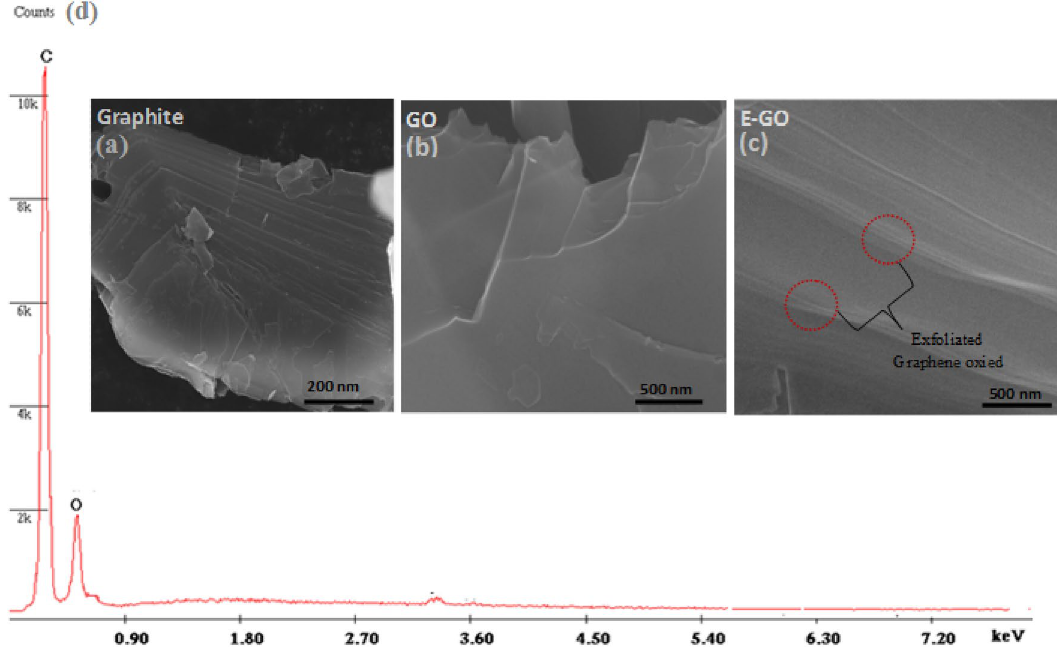
Figure 2. SEM image of the powdered ( a ) Graphite, ( b ) GO, and ( c ) E-GO sample and the EDX spectra.